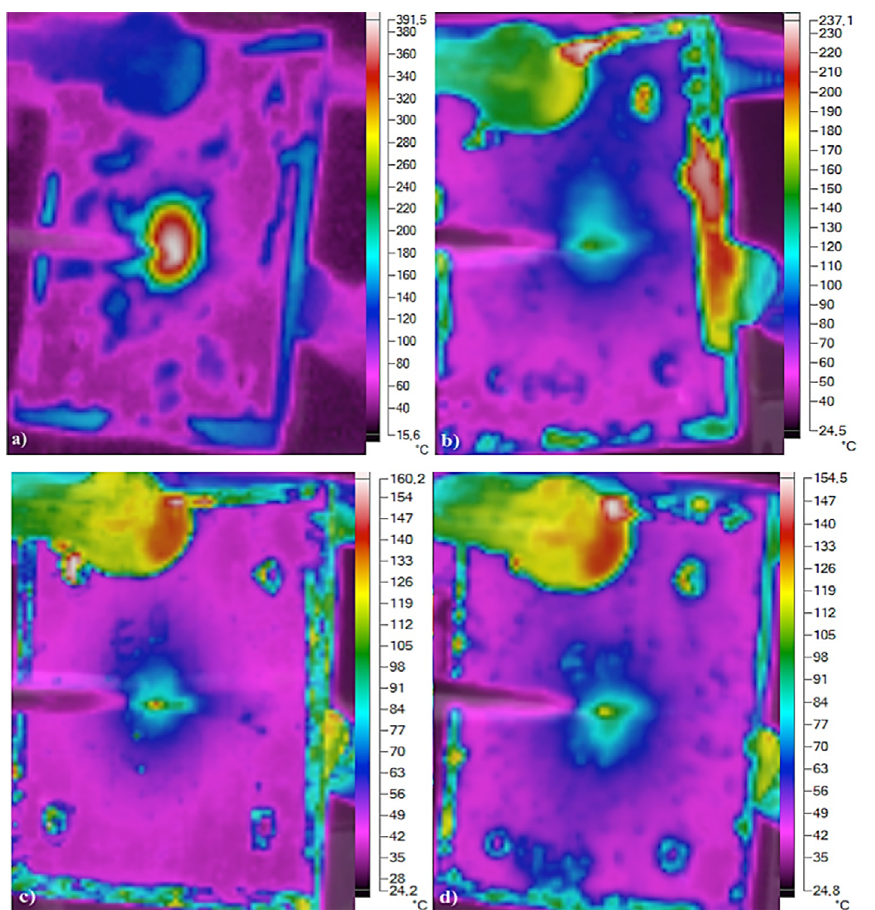
Figure 4. Temperature distribution for the TAN5 sample after 30 min of blowtorch application: a) TAN5, b) TAN5-BM, c) TAN5-P and d)